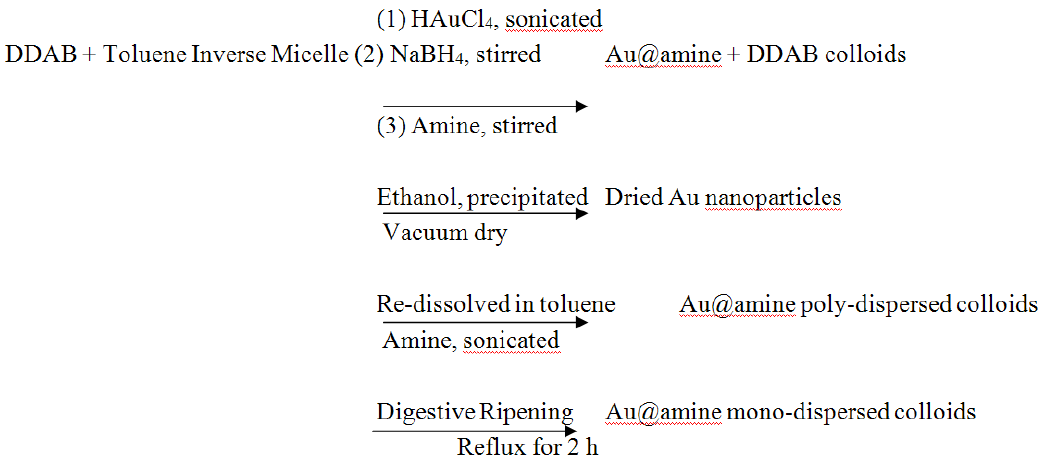
Figure 1. Schematic representation of the synthesis of gold colloid by inverse micelle method and digestive ripening